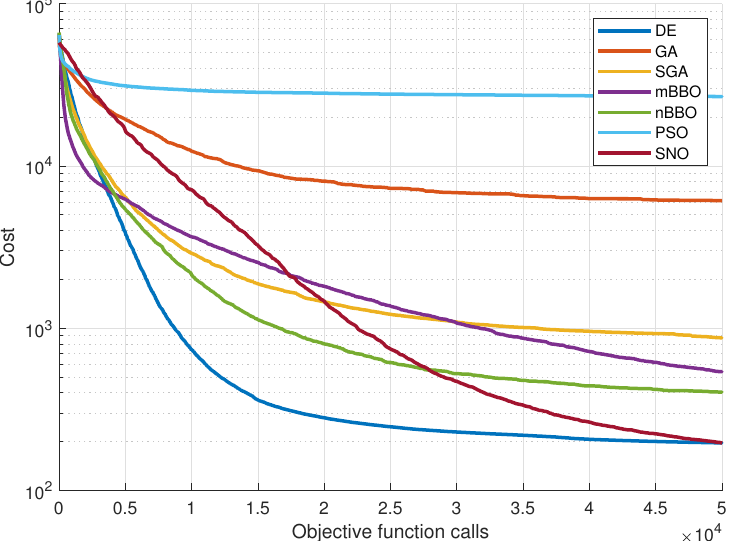
Figure 7. Average convergence curves for the analyzed